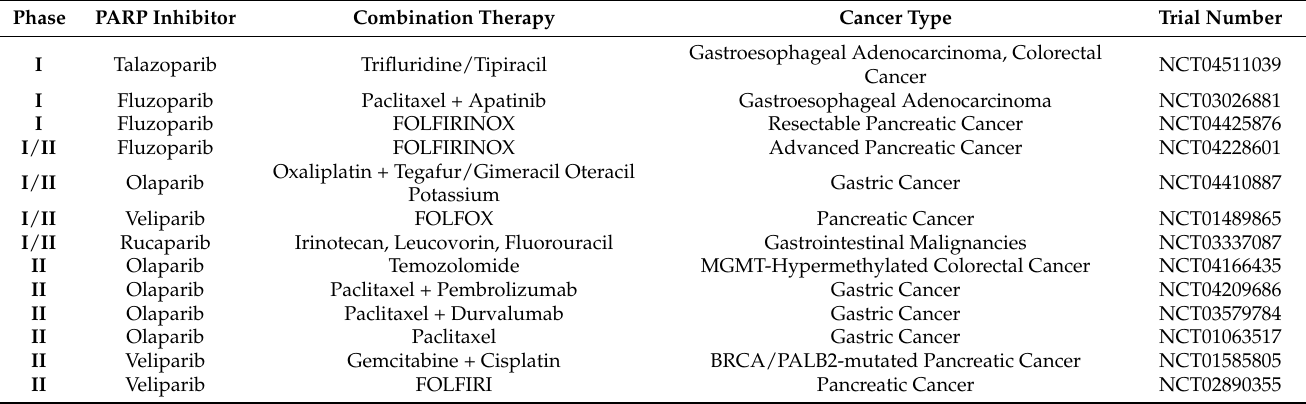
Table 1. Ongoing clinical trials assessing the combination of PARP inhibitors with chemoradiotherapy in GI cancers.